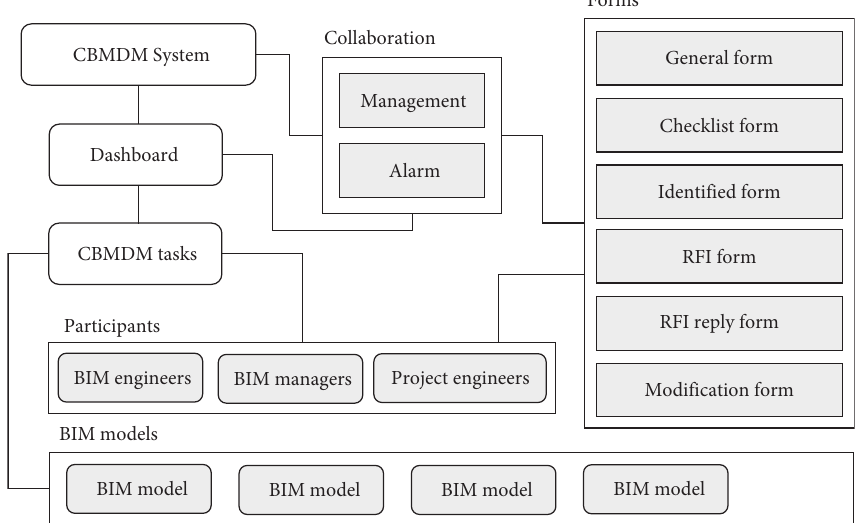
Figure 2: The usage of CBMDM forms in the CBMDM